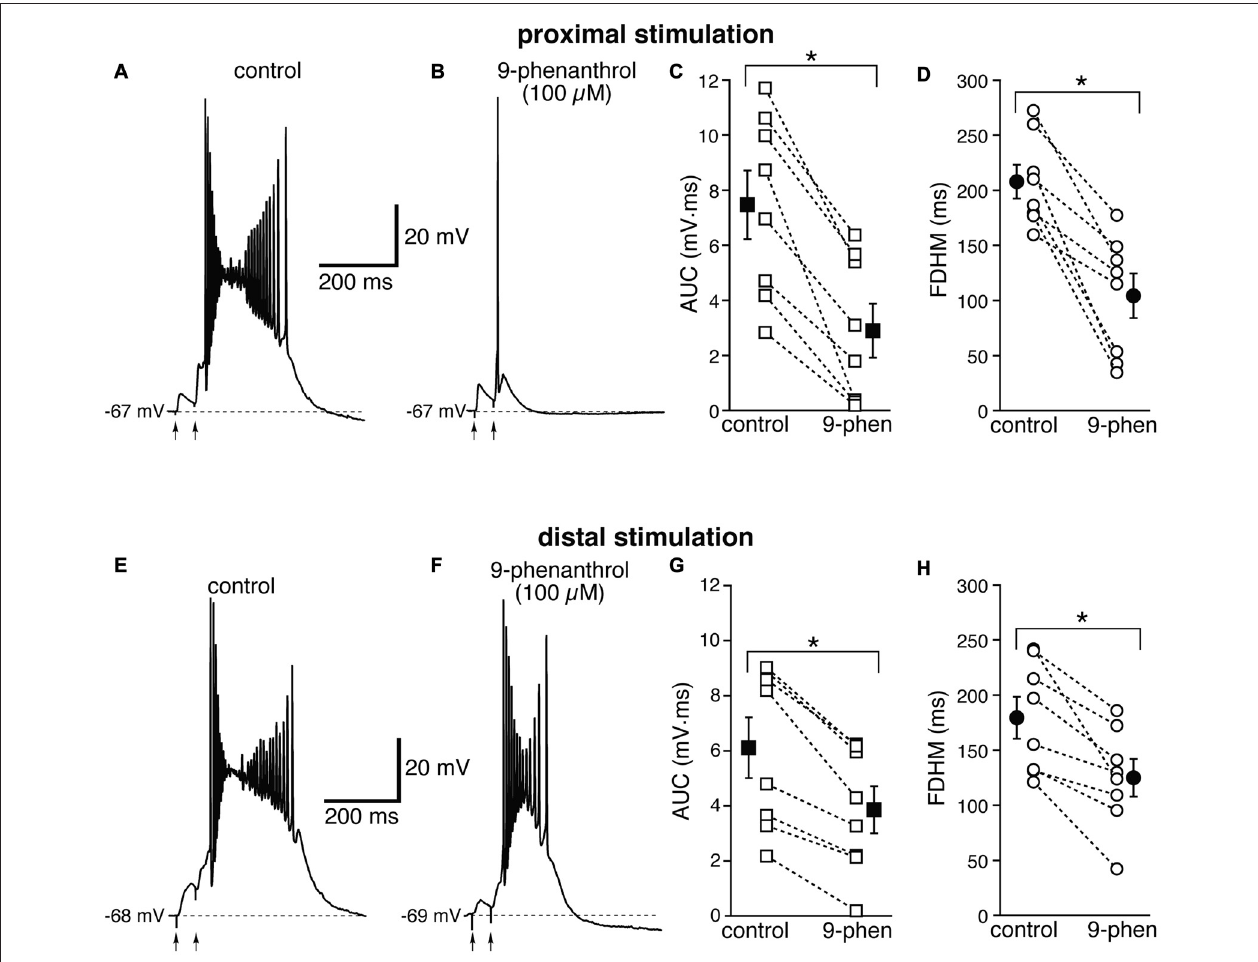
FIGURE 9 | The effect of 9-phenanthrol on the depolarizing plateau and hyperexcitability differs depending on the location of the stimulation. Top, representative trace of the response elicited by synaptic stimulation in control conditions (A) and in the presence of 9-phenanthrol (100 µ M, B ). The perfusion of 9-phenanthrol changed the response from a burst into a single AP in four out of eight neurons. This fact is reflected in the striking reduction in the average AUC (by 67 ± 9%, C ) and the FDHM (by 50 ± 9%, D ). Bottom, representative trace of a burst recorded upon stimulation of distal afferent fibers in control conditions (E) and in the presence of 9-phenanthrol (F) . 9-phenanthrol switched the response from a burst to a single AP in only one neuron out of eight. In addition, 9-phenanthrol significantly reduced the average AUC (by 42 ± 8%, G ) and the FDHM (by 31 ± 7%, H ) in n = 8 neurons. Asterisks indicate significant difference between control and 9-phenanthrol. There was a statistically significant interaction between the 9-phenanthrol treatment and location for both the AUC ( p = 0.001) and the FDHM ( p = 0.009, two-way repeated measures ANOVA). The traces in (A,B) and (E,F) were recorded from the same